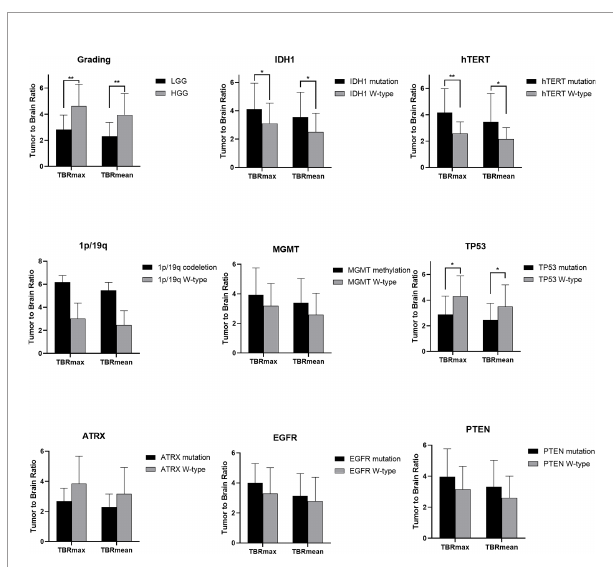
FIGURE 3 | Statistic results of grading, IDH1/2, 1p/19q, MGMT, hTERT, TP53, PTEN, EGFR, ATRX mutations status and TBR (*P < 0.05, **P <